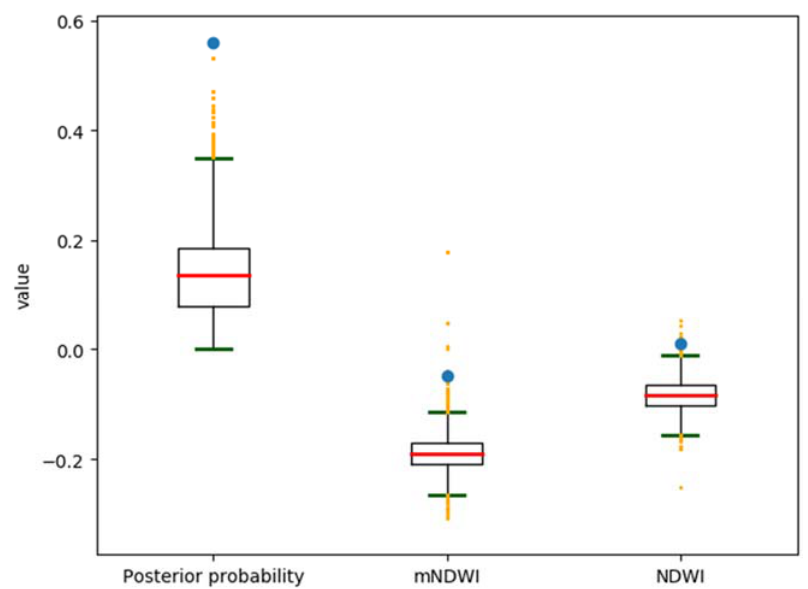
Figure 13. Boxplots of posterior probability, mNDWI, and NDWI values of hill shade pixels in the Yingluoxia reach (blue dots represent the optimal thresholds).